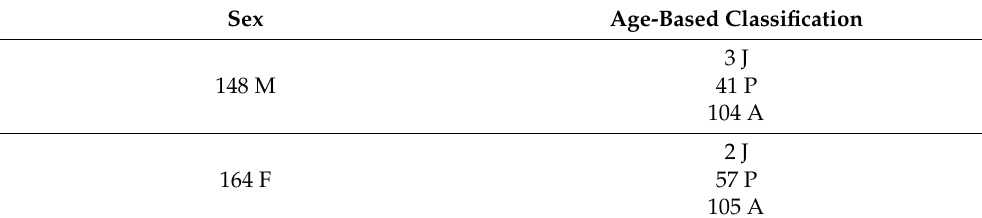
Table 1. Screened population for HEV RNA detection. Sex Age-Based Classification 148 M